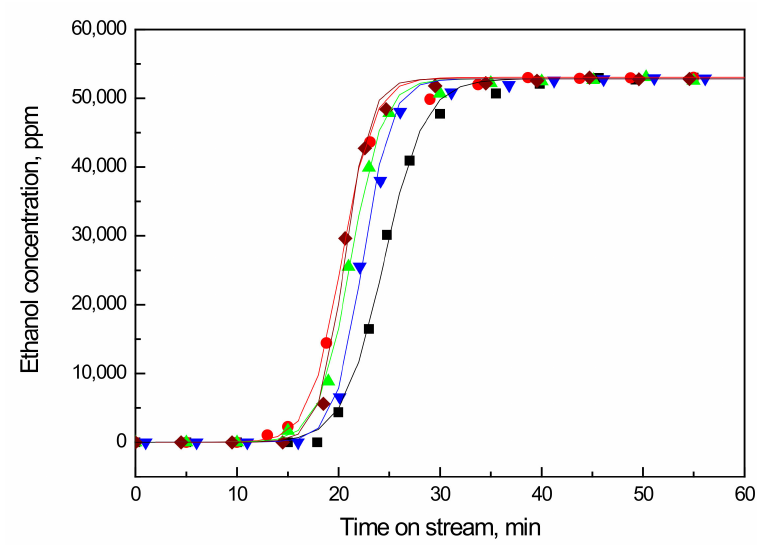
Figure 1. Breakthrough curves for V f (black), V r300 (red), V r350 (green), V r400 (blue), and V r450 (wine); solid line represents the calculated data with parameters shown in Table